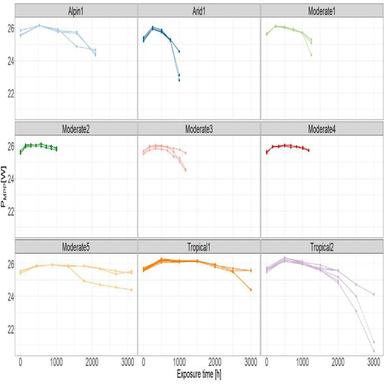
Changes in PMPP over exposure time for the test modules exposed to the various climate specific ageing tests.